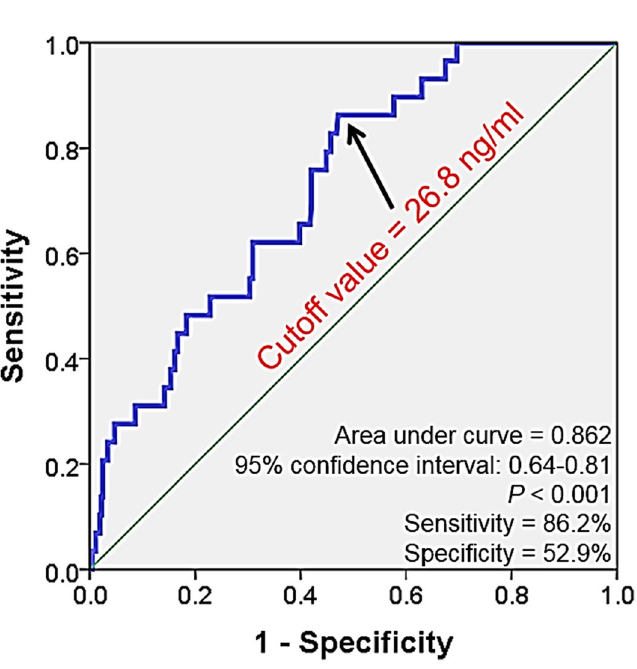
Figure 2. Receiver operating curve analysis showing cutoff value of soluble ST predicting major adverse cardiac